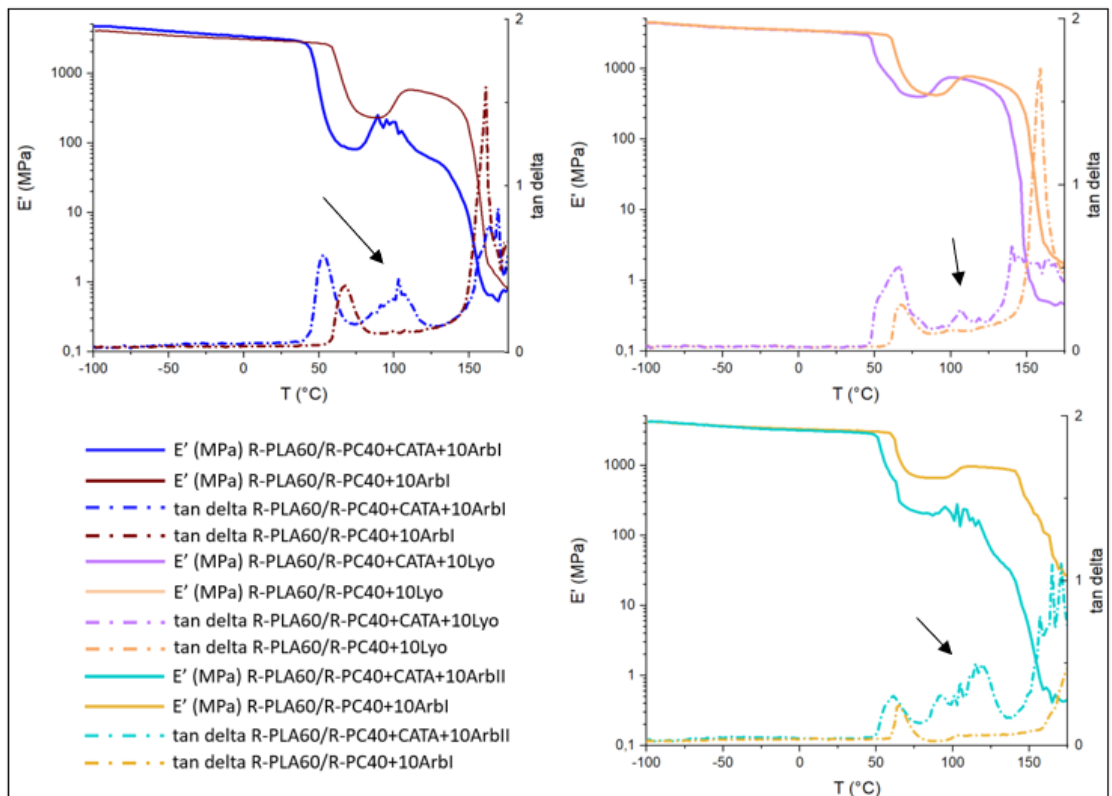
Figure 3. E’ and tan delta evaluation sweeping temperature for all the biocomposites produced. The black arrows represent tan delta